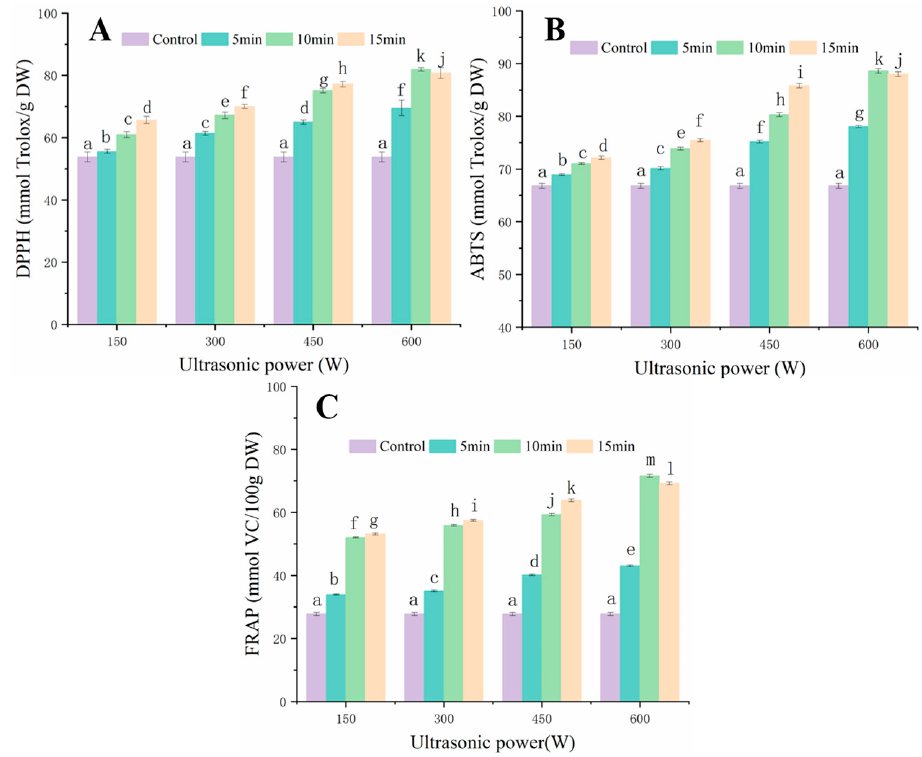
Figure 5. The free radical scavenging rate of FSI. DPPH ( A ); ABTS ( B ); and FRAP ( C ) of the FSI after UAVD. Different letters in the histogram indicate that the extraction time points within UAVD are significantly different ( p < 0.05).